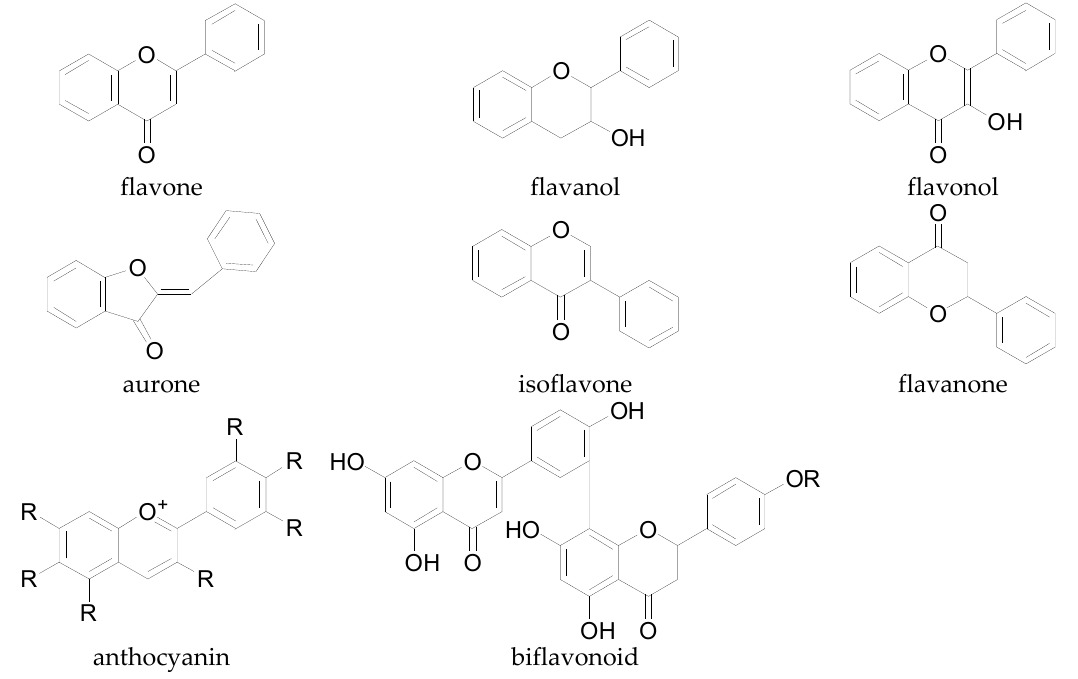
Figure 11. Base structures of the different classes of flavonoids.